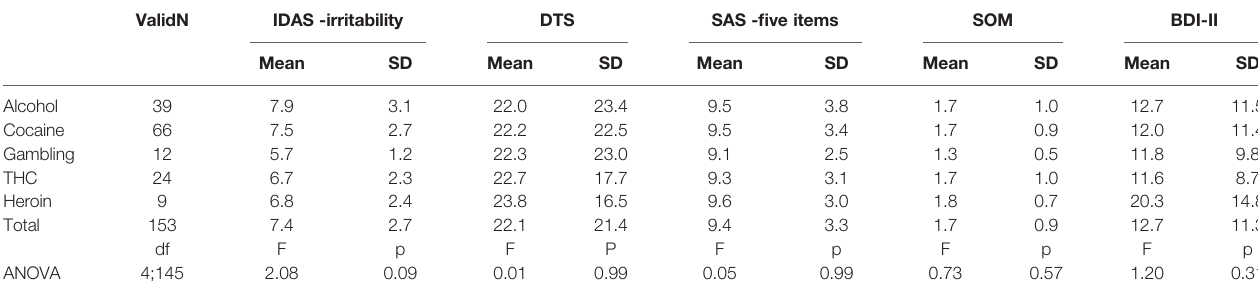
TABLE 3 | Results of the psychometric scales and substances/behaviors, ANOVA results. ValidN